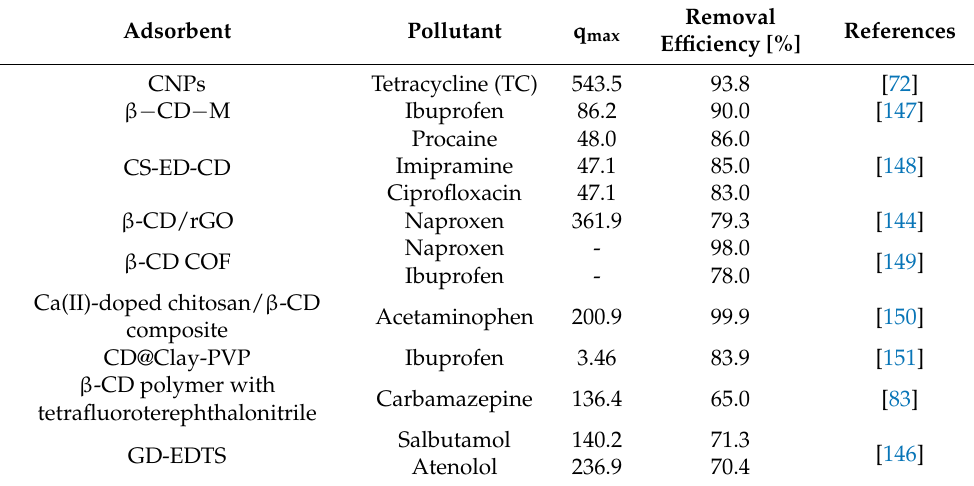
Table 4. Maximum adsorption capacities and removal efficiencies of various CD-based adsorbents for selected pharmaceutical